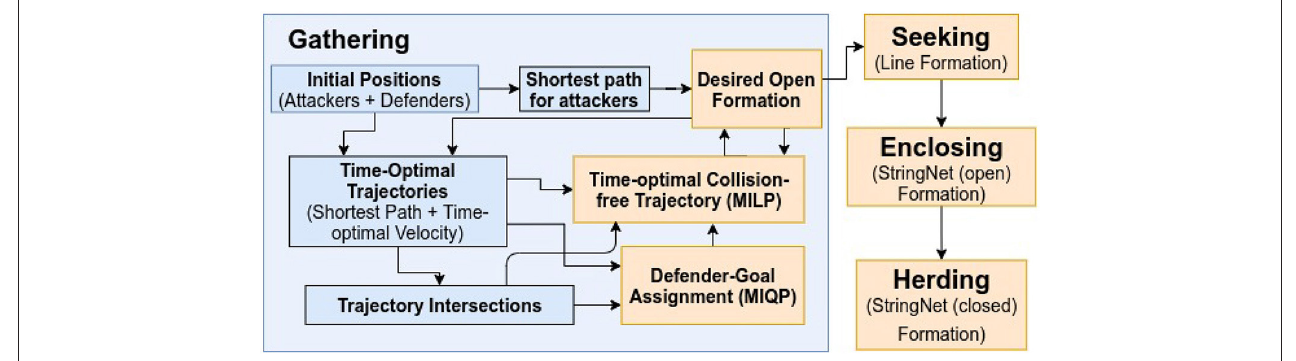
FIGURE 2 | Block diagram for “StringNet